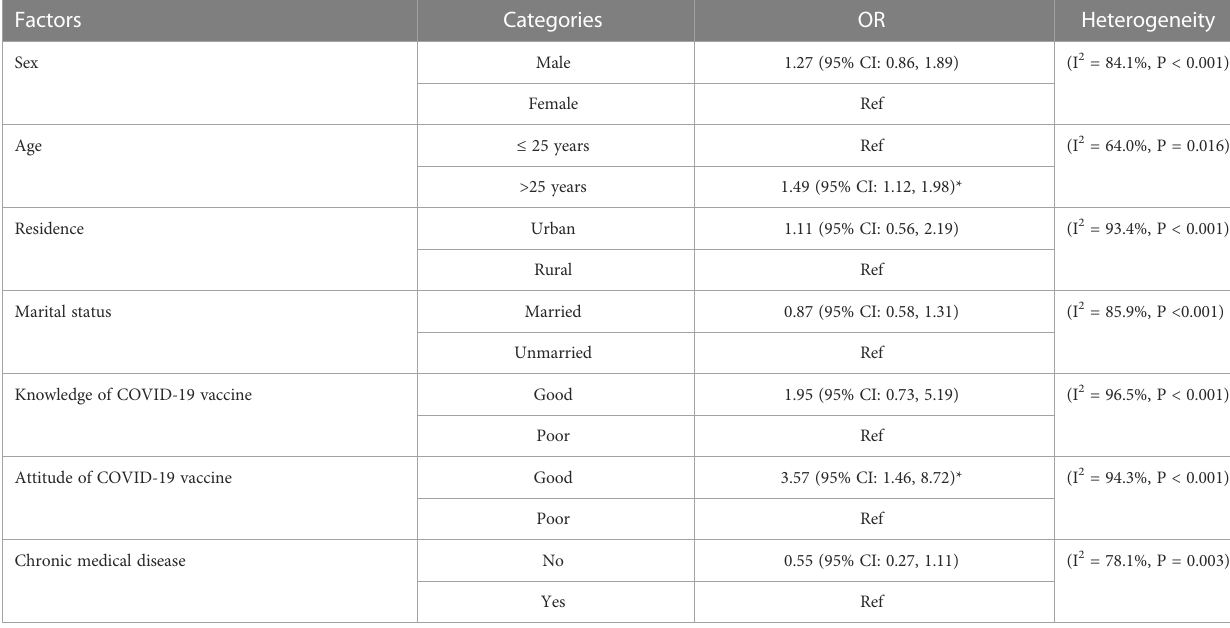
TABLE 2 Determinants of willingness to accept COVID-19 vaccine in Ethiopia. Factors